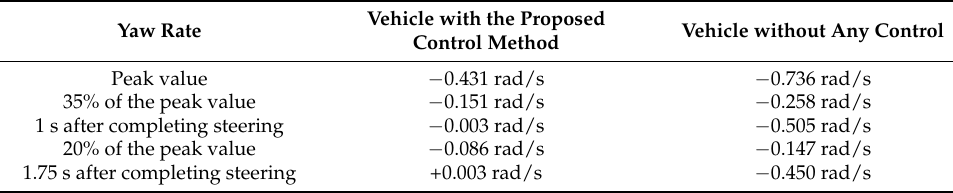
Figure 4. Comparison of the vehicles with and without the proposed optimal torque distribution control: (a) yaw rate responses; (b) sideslip angle responses. Table 5. Evaluation of the Sine with Dwell (SWD) test.